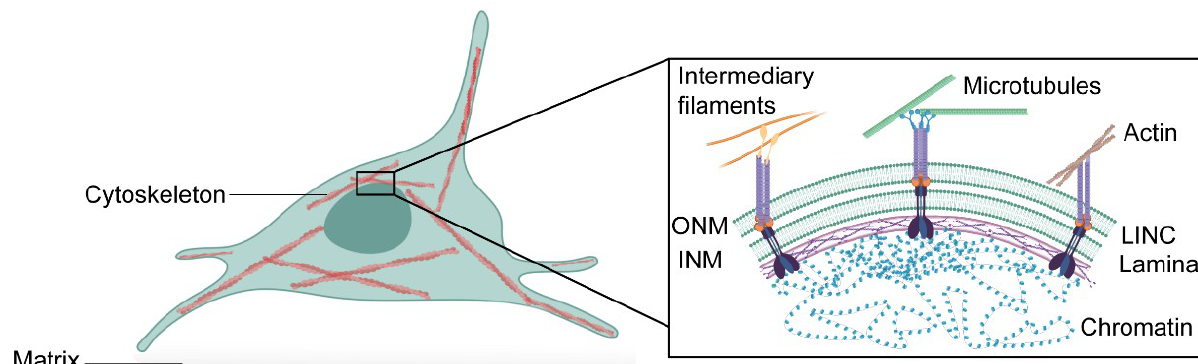
Figure 1. Schematic representation of the interconnectivity between cytoskeleton, nuclear envelope and chromatin. The cytoskeleton is physically connected to the nuclear envelope consisting of the outer nuclear membrane (ONM) and the inner nuclear membrane (INM) through the LINC complex. The LINC complex is formed of trimers of SUN-domain proteins that bind different KASH-domain proteins at the nuclear membrane. LINC complexes can indirectly associate with intermediary filaments and microtubules through cyto-linker proteins or motor proteins, respectively, or directly interact with actin filaments. At the nuclear interior, the nuclear lamina tethers chromatin domains—lamina-associated domains—to the nuclear envelope. This allows effective mechanotransduction in the cell.